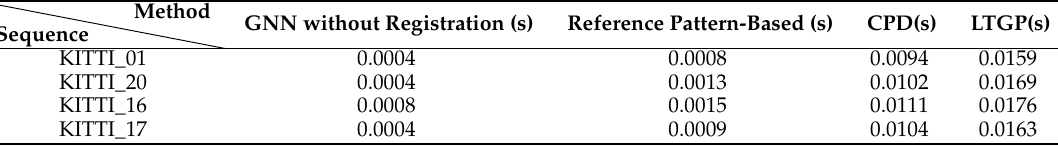
Figure 10. Track-to-track association matching accuracy of the GNN without registration, reference pattern-based algorithm, CPD algorithm and proposed LTGP method under different sequences of KITTI dataset. Table 1. The average run-times of these algorithms in four KITTI